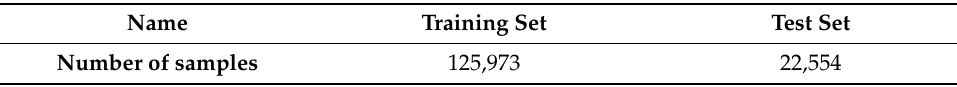
Table 2. Training set and test set size.